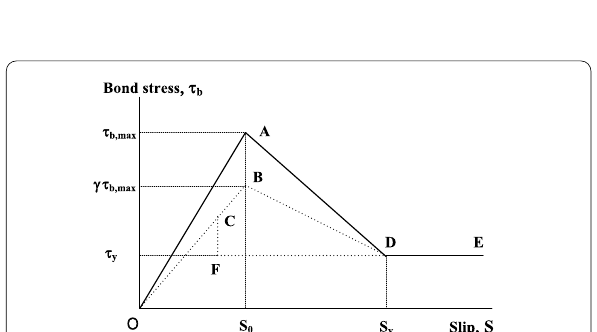
Fig. 2 Idealized bond stress–slip relationship (Kim et al., 2006).